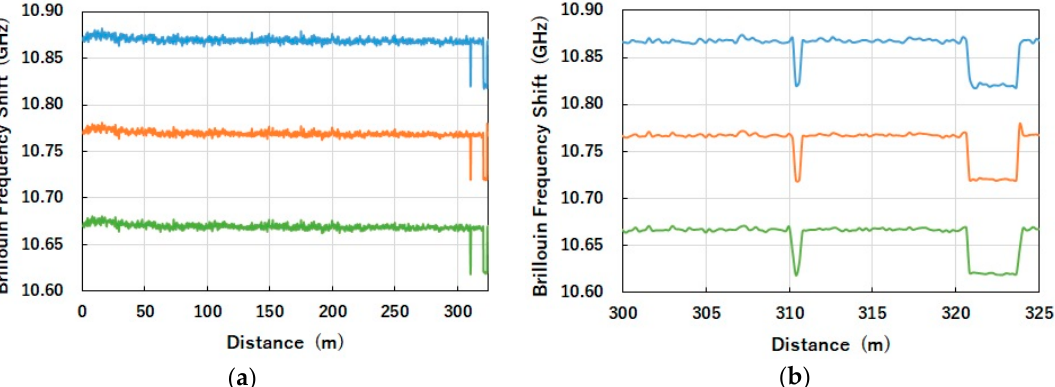
Figure 6. Brillouin frequency shift (BFS) distributions evaluated using three spectra, B a ( ω ) , B r ( ω ) and B i ( ω ) , shown by blue, orange and green curves, respectively. Frequency offset is added to orange and green curves for ease of viewing. ( a ) Whole map, ( b ) expanded view; T L = 20 ns, T S = 2 ns, and T I = 0.5 ns.